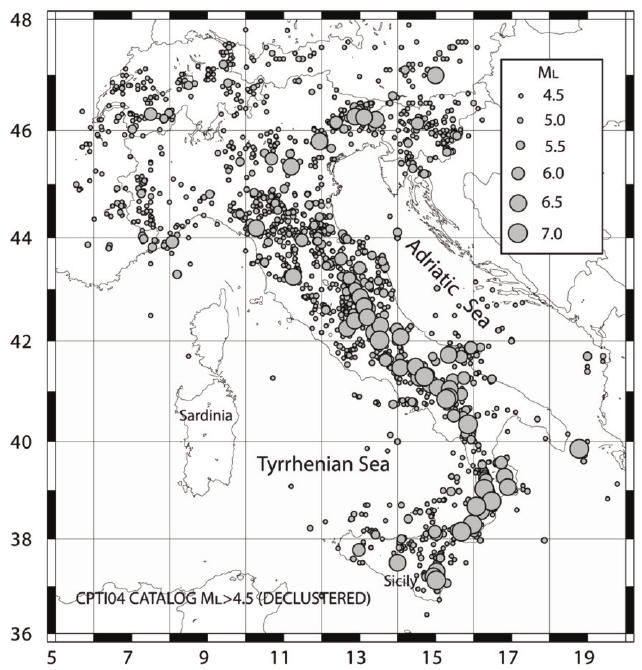
≥ 4.65) reported in w